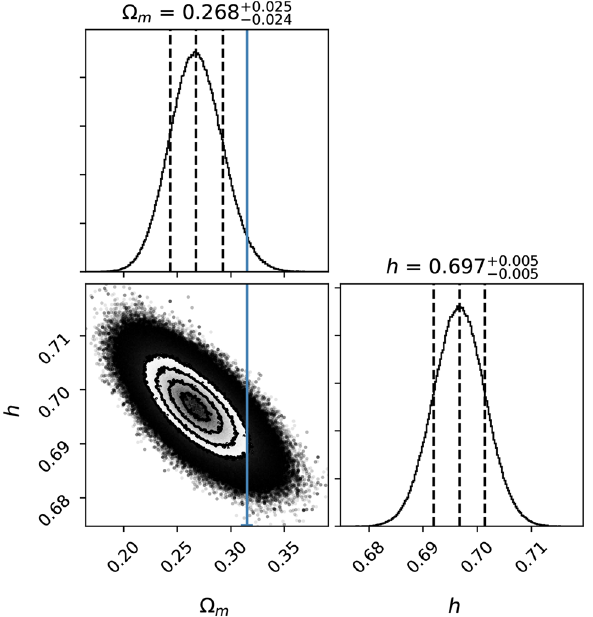
Fig. 1 MCMCsimulationresultsforthe Λ CDM-model’s(Eq.11)cos- mological free parameters ( Ω m and ¯ h ), with “true” values (blue lines: Ω = 0 . 315and ¯ h = 0 . 674)providedbythePlanck2018collaboration m data release [7]. We used 100 random walkers and 25 000 iterations